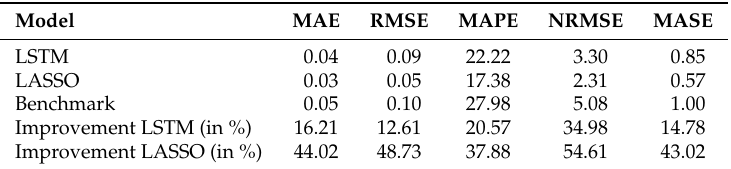
Table 3. Median of error measures for the prediction of energy consumption across all 88 consumer datasets.